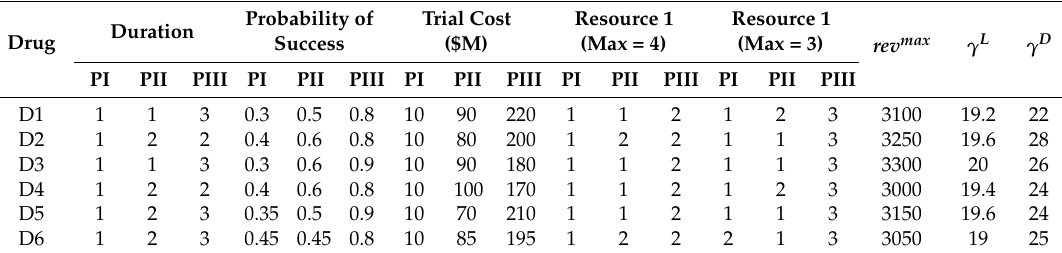
Table A5. Parameters for a six-drug case study.